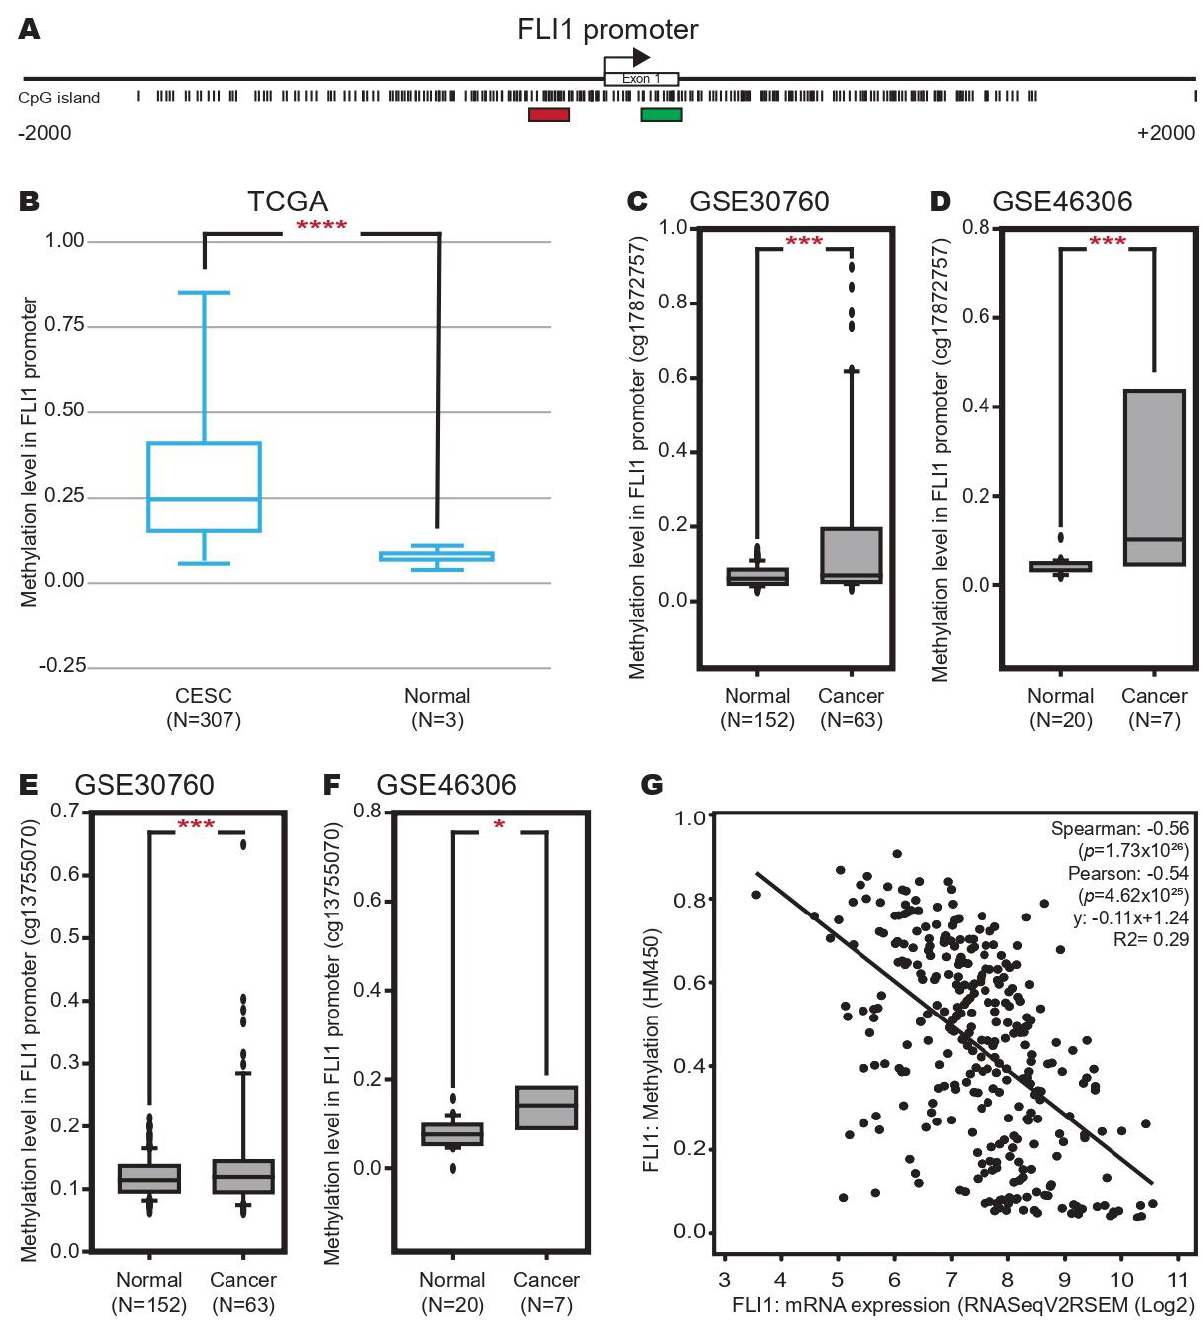
Figure 3. Methylation in the FLI-1 promoter increases in cervical cancer tissue. ( A ) CpG island at the FLI-1 promoter. The CpG island is located in a region ±2 kb around the TSS. Red box: localization of probe cg13755070. Green box: localization of probe cg17872757. ( B ) Methylation level at FLI-1 promoter in the CC and normal tissue samples from the TCGA dataset. ( C ) Methylation level at the FLI-1 promoter in the CC and normal tissue samples from the GSE30760 dataset (probe cg17872757). ( D ) Methylation level at the FLI-1 promoter in the CC and normal tissue samples from the GSE46306 dataset (probe cg17872757). ( E ) Methylation level at the FLI-1 promoter in the CC and normal tissue samples from the GSE30760 dataset (probe cg13755070). ( F ) Methylation level at the FLI-1 promoter in the CC and normal tissue samples from the GSE46306 dataset (probe cg13755070). ( G ) Correlation between the methylation and FLI-1 expression in patients with CC from the TCGA dataset. * p -value ˂ 0.05, *** p -value < 0.001 and **** p -value < 0.0001.